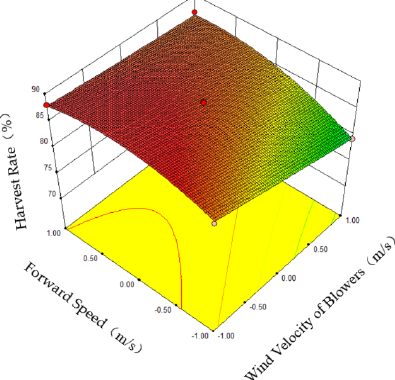
Figure 20. Interaction between forward speed and wind velocity of blowers.